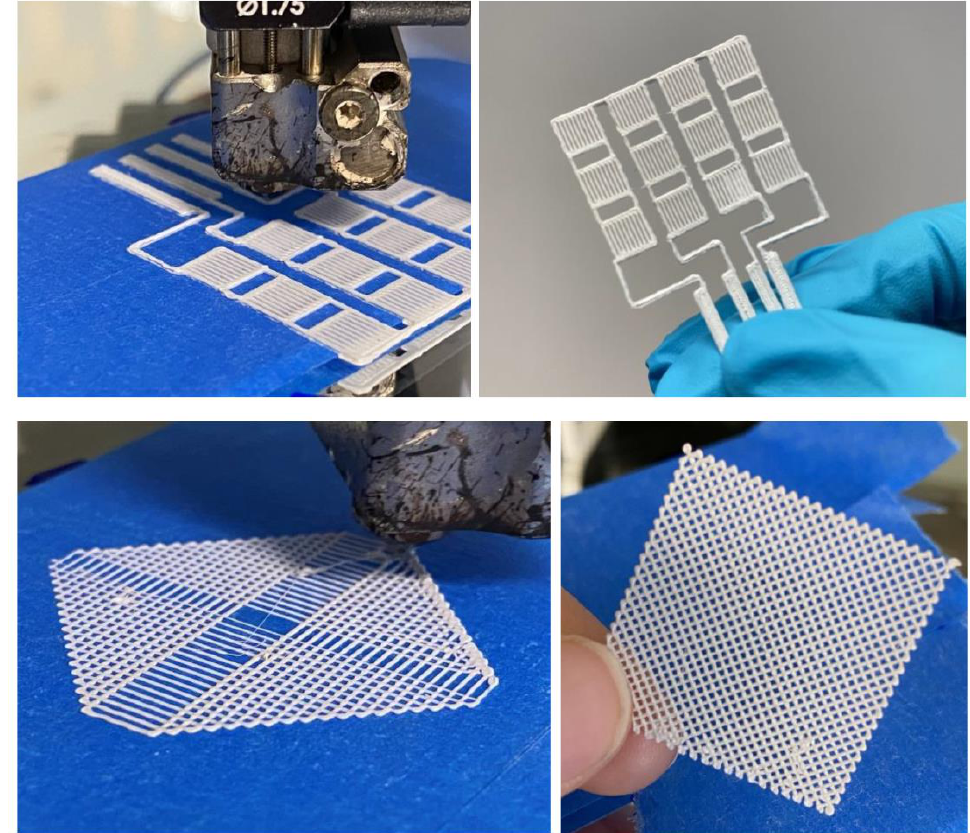
Table 4. Setting the parameters of the laboratory 3D thermal printer.